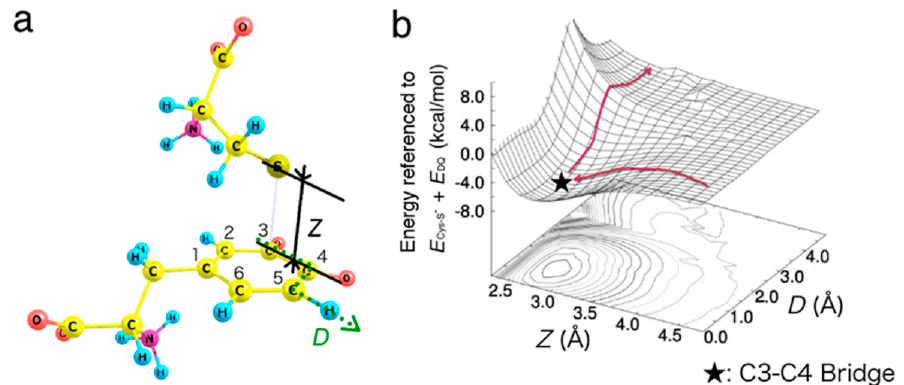
Figure 4. Migration of Cys − S − on the benzene ring of DQ. ( a ) Interaction model between Cys–S − and DQ with two variables, Z and D . ( b ) Potential energy surface for the approaching/migration of Cys–S − on DQ around C3–C4 and C5. Energies are referenced to the sum of total energy of isolated systems, i.e., Cys–S − and DQ ( E Cys–S − + E DQ ). The benzene ring carbon atoms, and all the Cys − S − atoms were fixed, and the other degrees of freedom were